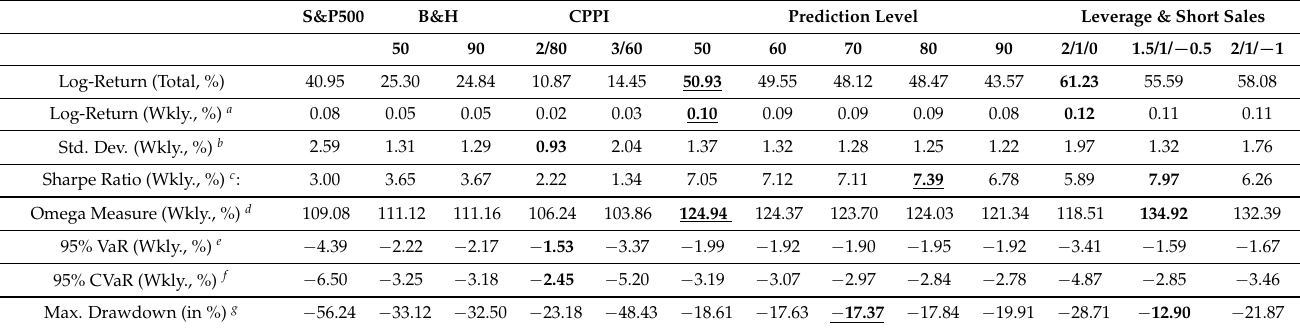
Table A10. Comparison of trading strategies for the out-of-sample period from 30 December 2005 until 5 February 2016.